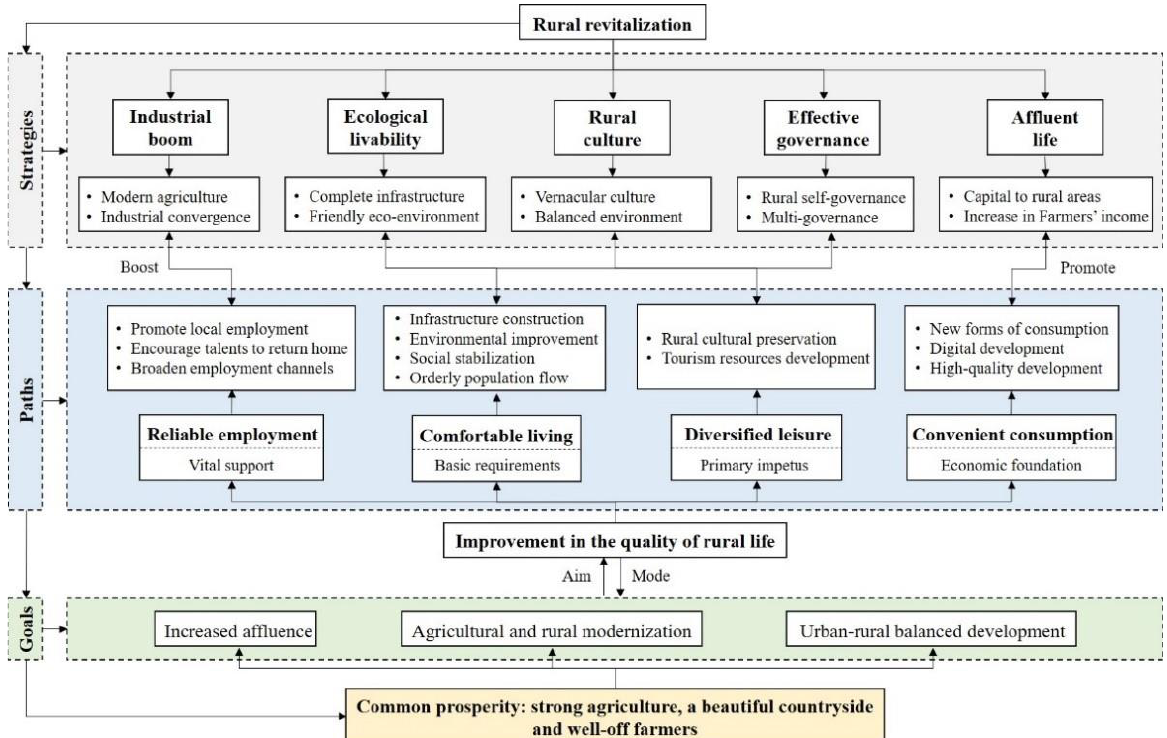
Figure 2. Theoretical framework of QRL.